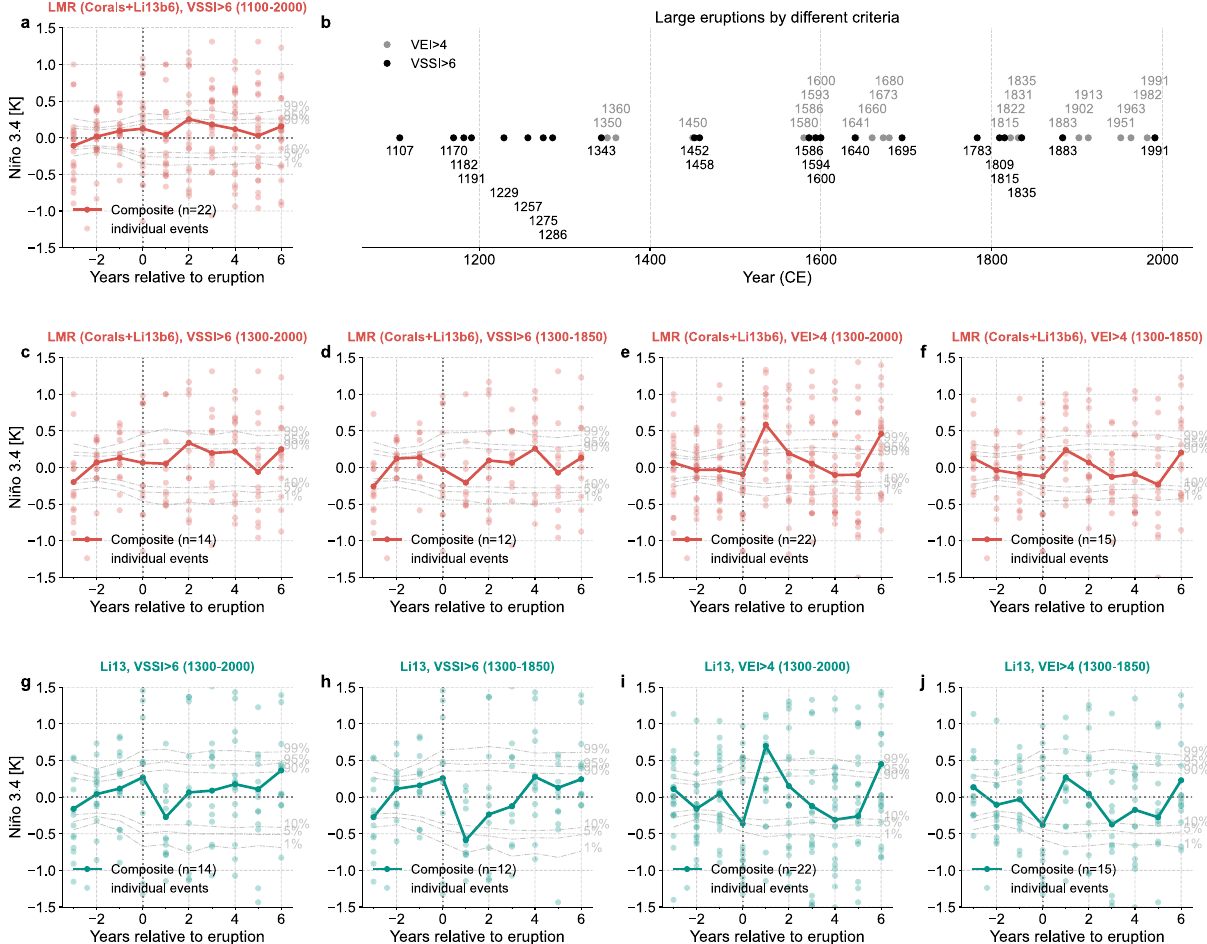
Fig. 4 A superposed epoch analysis (SEA) comparison between the last millennium reanalysis (LMR) 31,32 reconstruction and the Li et al. 12 reconstruction. a SEA of the Niño 3.4 reconstruction LMR (Corals + Li13b6) regarding all the 22 events over the past millennium. b The large eruption events de fi ned by different criteria: the volcanic explosivity index 47 greater than 4 (VEI > 4) and the volcanic stratospheric sulfur injection greater than 6 (VSSI > 6). c – f Superposed epoch analysis (SEA) of LMR (Corals + Li13b6) regarding the de fi ned large eruption events based on VSSI > 6 over 1300 – 2000 CE, VSSI > 6 over 1300 – 1850 CE, VEI > 4 over 1300 – 2000 CE, and VEI > 4 over 1300 – 1850 CE, respectively. g – j Same as subplots ( c – f ), but for the Li et al. 12 reconstruction (denoted as Li13).